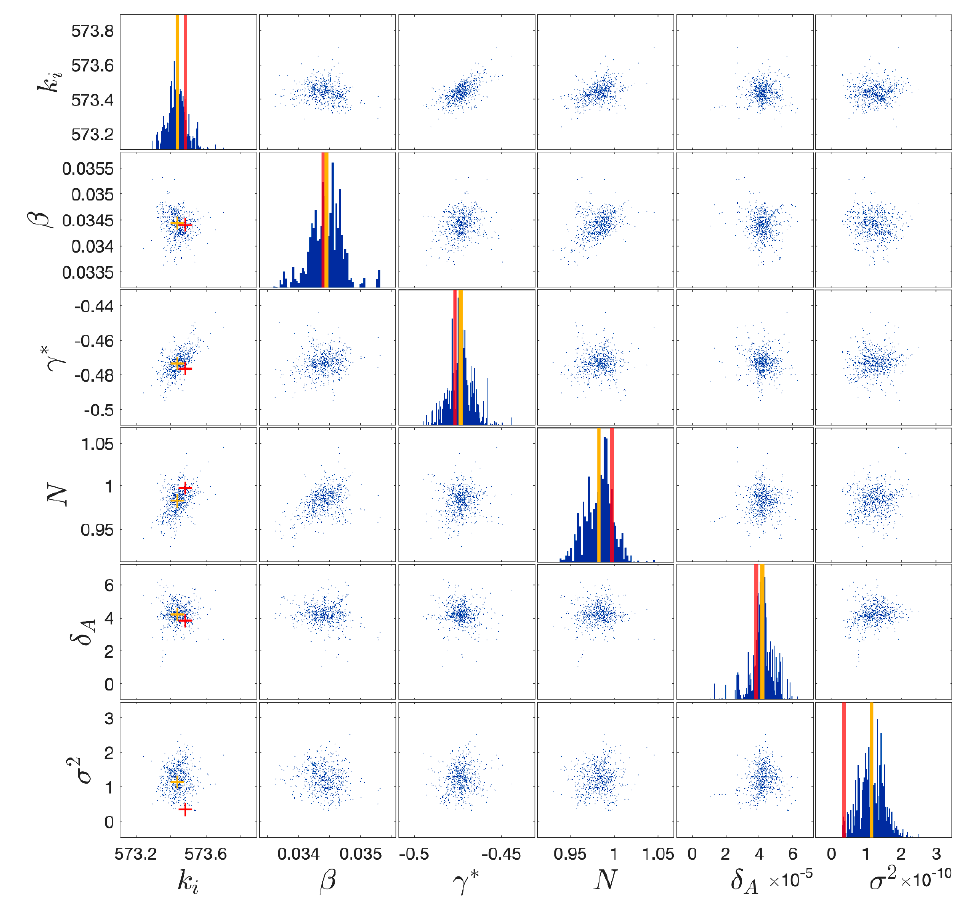
Figure 10. Posterior samples of the BWBN model parameters for the case study. The vertical lines denote the mean of the distribution (in yellow) and the maximum a posteriori estimate (MAP) (in red). Appl. Sci. 2020 , 10 , x FOR PEER REVIEW